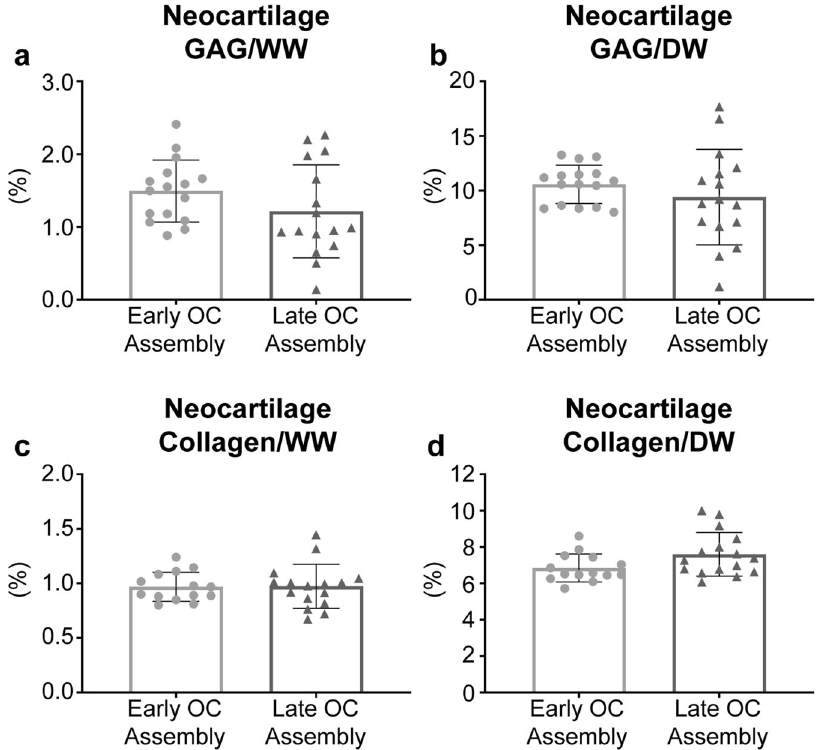
Fig. 4 Neocartilage biochemical properties at the end of 5 weeks of culture. a GAG/wet weight (WW), ( b ) GAG/dry weight (DW), ( c ) collagen/WW, ( d ) collagen/DW contents are shown. Data are presented as means with errors bars representing standard deviations. Data were analyzed with a student ’ s t -test, and no statistical differences between groups were detected. GAG glycosaminoglycans, WW wet weight, DW dry weight, OC osteochondral.